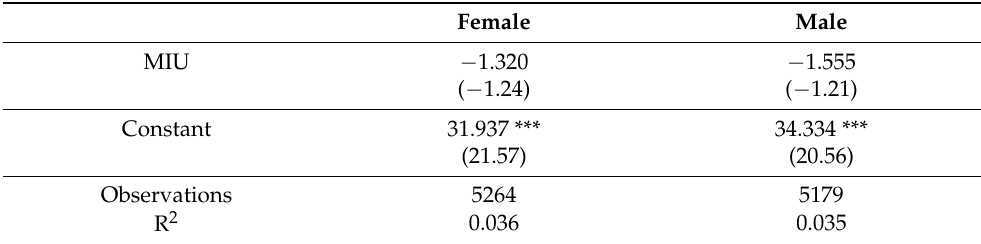
Table 8. Heterogeneous effects